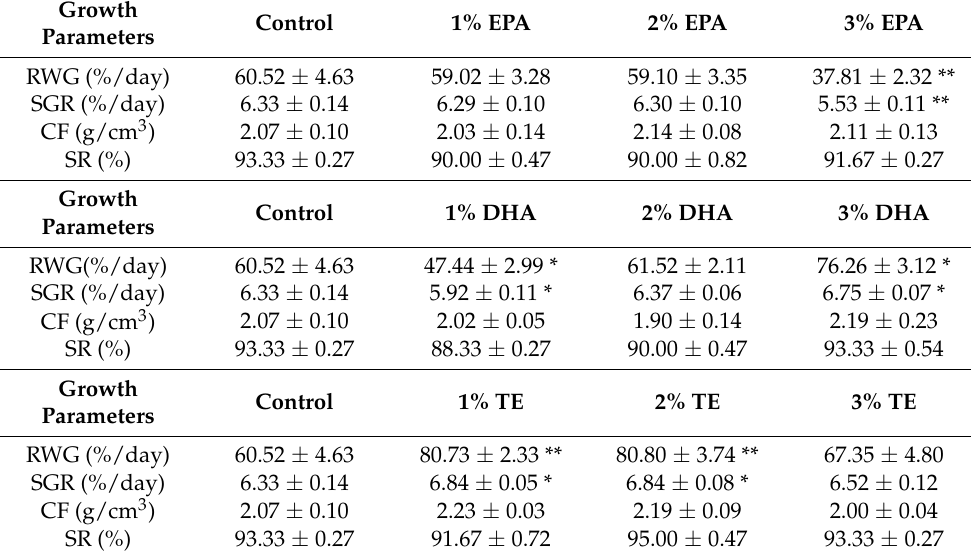
Table 1. Effects of various diets on zebrafish